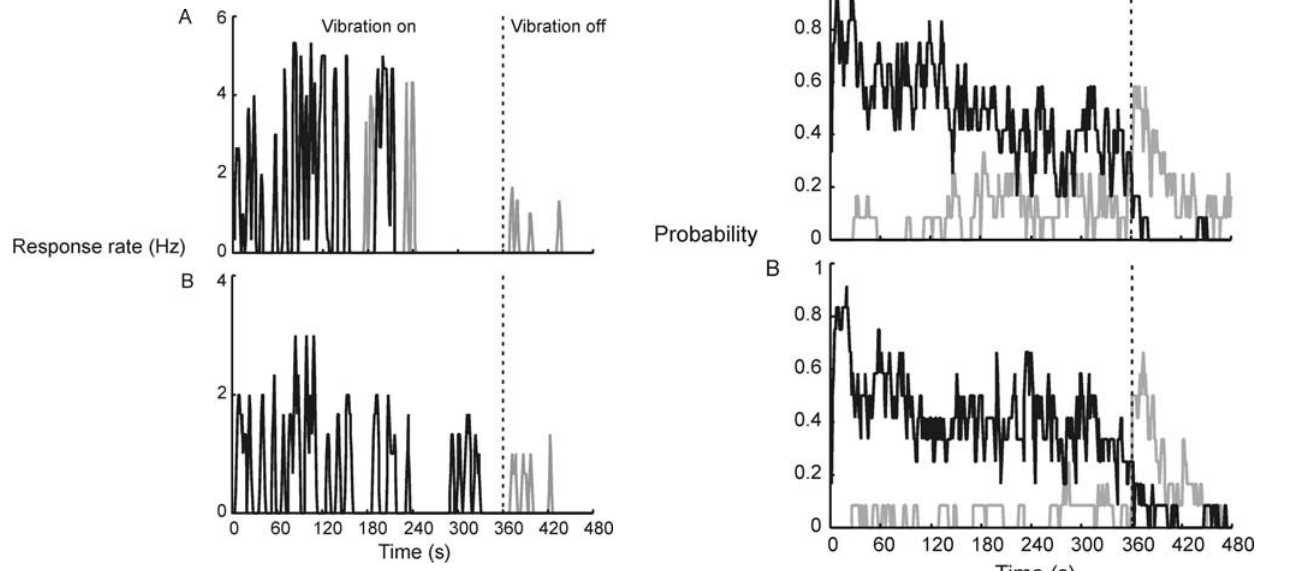
Figure 2. Probability of responding as a function of time recorded with 1-second precision (N=12). Black line indicates probability of perceived elbow extension (Pext) and the grey line, of flexion (Pflex). Participants had the option of not pressing either key (‘silence’), in the absence of a clear feeling of movement. Thus, for any given second, Pext + Pflex + Psilence=1. A. Results from Run 1. B. Results from Run 2.